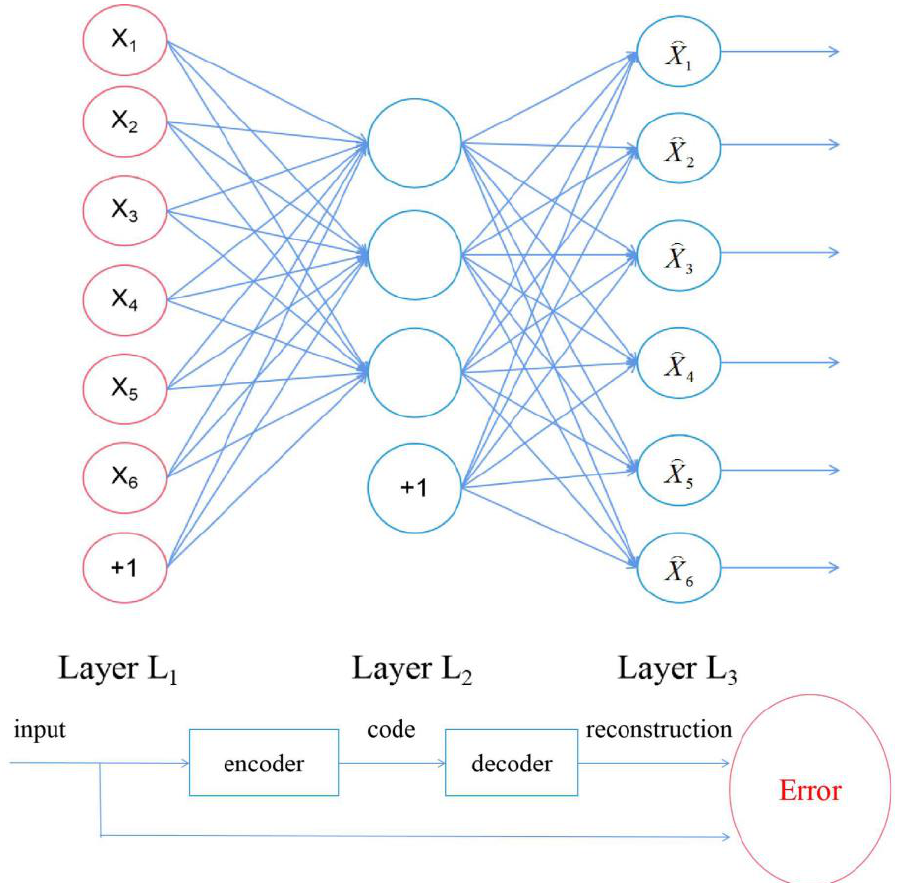
Figure 1. Auto encoder process.